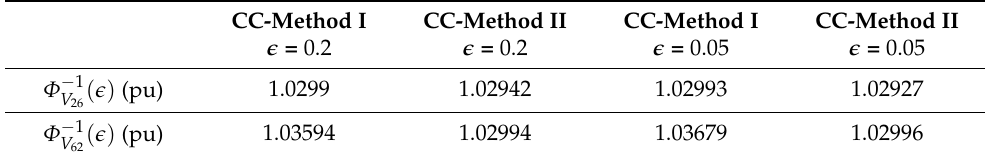
Table 3. Out-of-sample analysis of node voltages corresponding to the imposed confidence level obtained by the proposed CC